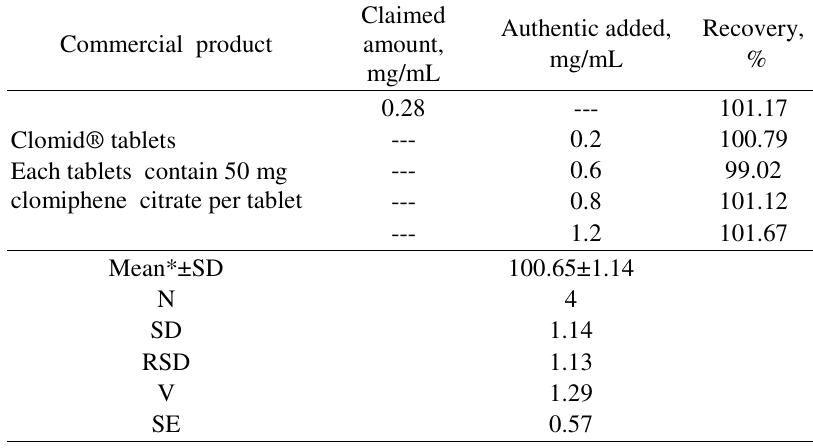
Table 5. Application of the proposed spectrophotometric method for the analysis of clomiphene citrate drug in dosage